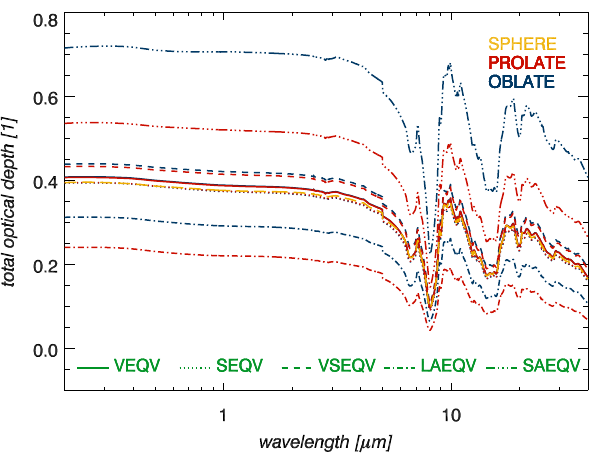
Fig. 8. Simulated spectral total optical depth of spherical (yel- low) and spheroidal mineral dust particles as measured on 19 May 2006 over OZT site about noon. Either prolate (red) or oblate (blue) shapes were considered when averaging over the measured AR dis- tributions (Fig. 1). Size equivalence cases were applied as discussed in Sect. 3.2.